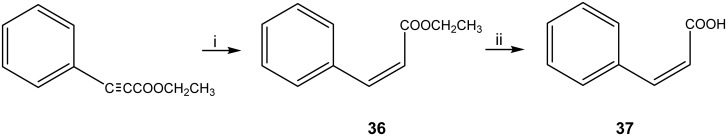
Synthetic scheme of compounds 36, 37.Reagents and conditions: i) Lindlar catalyst, H2, pyridine, MeOH, r.t., 16 h; ii) 1N NaOH, EtOH/THF (1:1), r.t., 12 h.